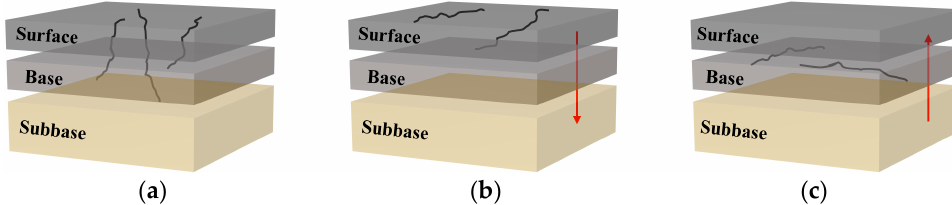
Figure 10. ( a ) The up and down cracking, ( b ) the top-down developing cracking, and ( c ) the bottom-up developing cracking.